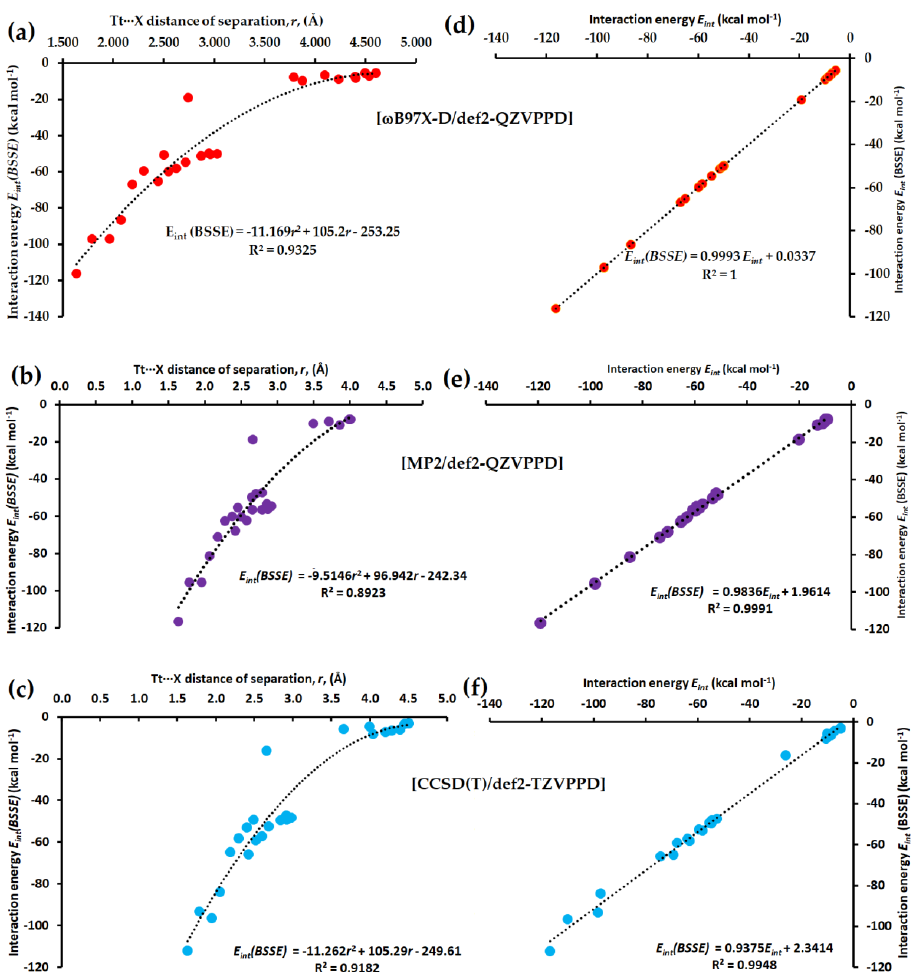
Figure 12. ( a ) The [ωB97X -D/def2-QZVPPD] level quadratic dependence of BSSE corrected interac- tion energy ( E int (BSSE) ) on the distance of separation r (Tt···X) for 25 [I 4 Tt···X − ] (Tt = C, Si, Ge, Sn, Pb; X = F, Cl, Br, I, At) molecule – anion complexes. Shown in ( b , c ) are the corresponding dependences obtained using [MP2/def2-QZVPPD] and [CCSD(T)/def2-TZVPPD], respectively. Shown in ( d – f ) are the linear dependences between E int (BSSE) and E int obtained with [ωB97X -D/def2-QZVPPD], [MP2/def2-QZVPPD] and [CCSD(T)/def2-TZVPPD], respectively.